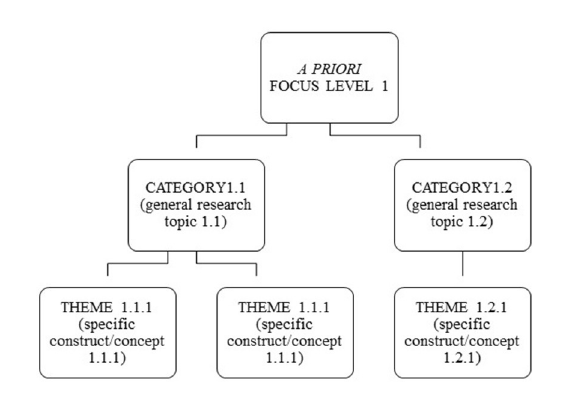
FIGURE3 The process of classifying identified empirical constructs and theoretical concepts in a previously defined focus level of study of the work and organizational